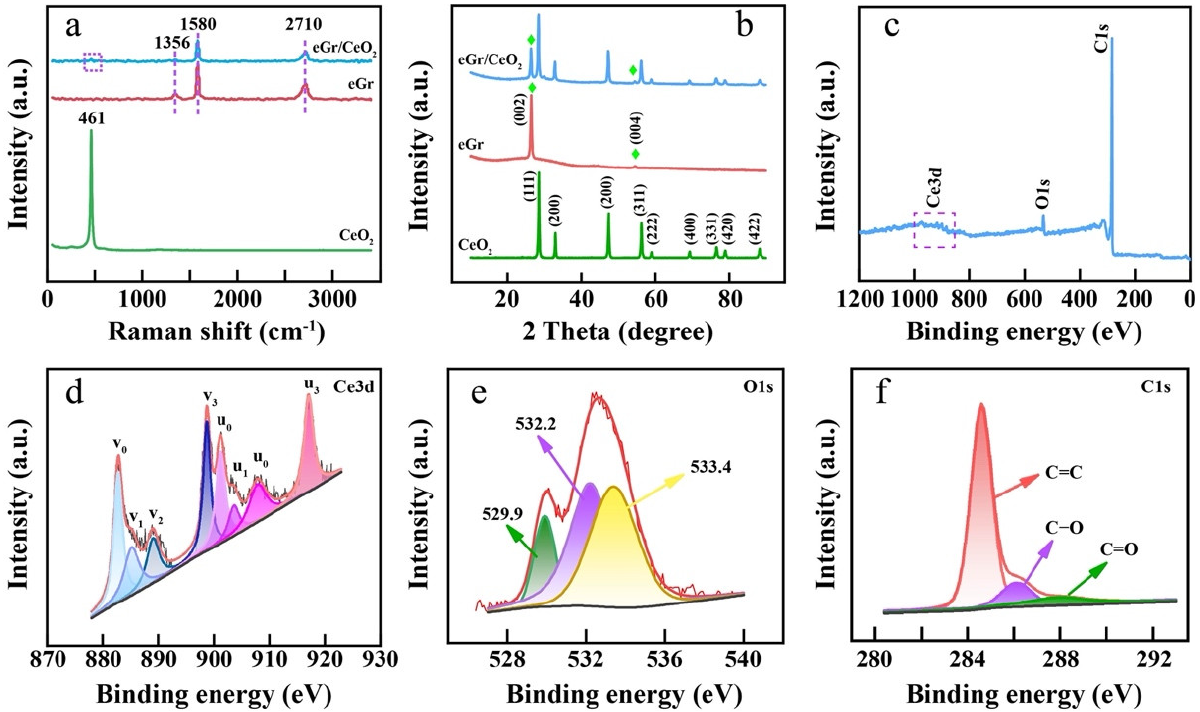
Figure 2. ( a ) Raman spectra, ( b ) XRD patterns of eGr, CeO 2 , and CeO 2 /eGr, ( c ) XPS survey spectrum, ( d ) Ce3d, ( e ) O1s and ( f ) C1s spectra of CeO 2 /eGr composite, respectively.